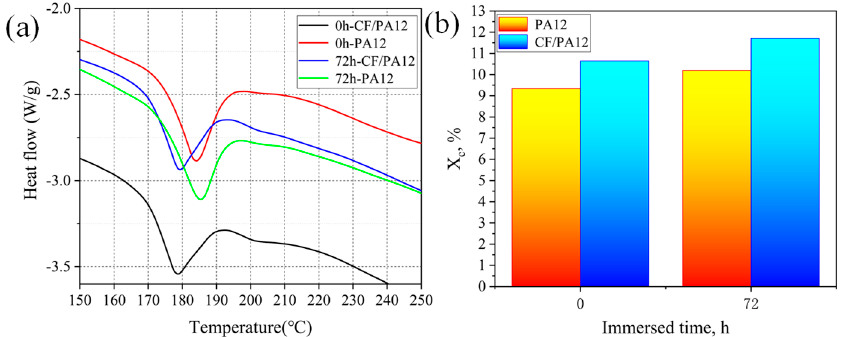
Figure 3. Effect of aging at water on ( a ) the melting peak and ( b ) the crystallinity ratio.